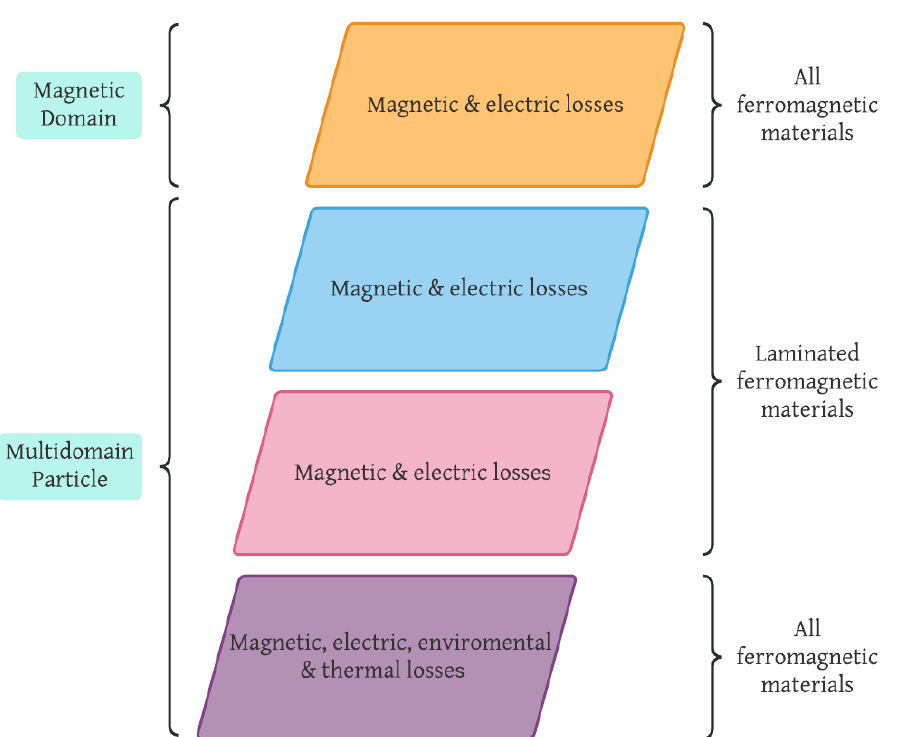
Figure 9. Power core losses models’ comparison depending on the size of the phenomena analyzed, kind of losses to calculate and ferromagnetic materials. Features of mathematical models, time- domain approximations, loss separation, and empirical methods are in color yellow, blue, pink, and purple,